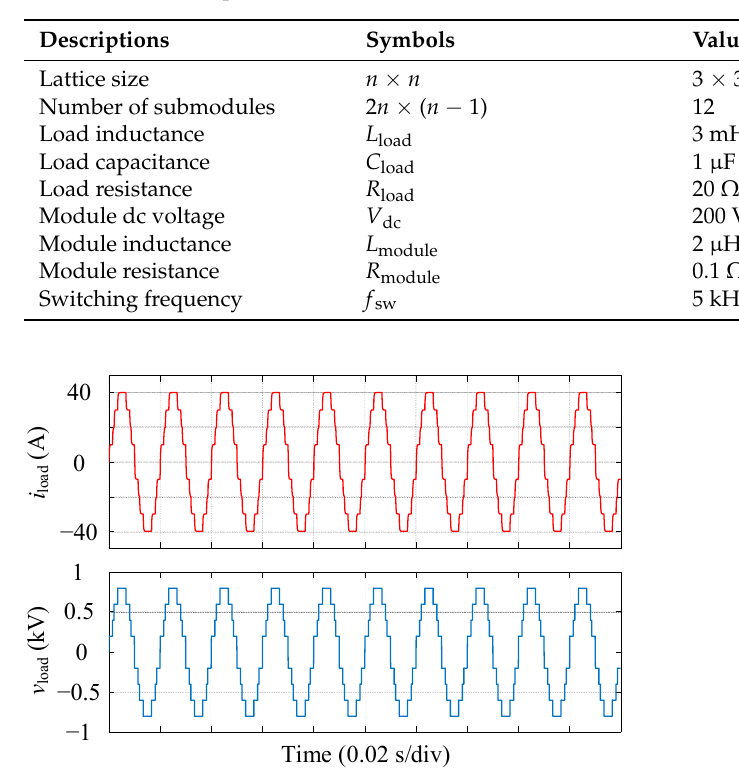
Table 1. Simulation parameters of lattice converters.